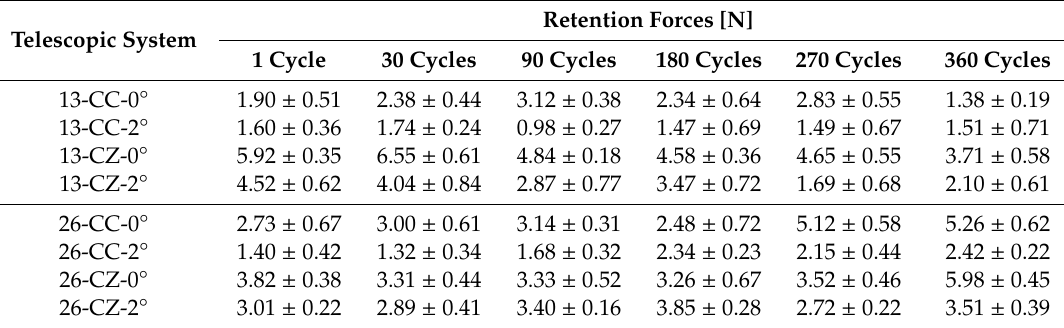
Table 2. Retention forces registered for the telescopic systems. Telescopic